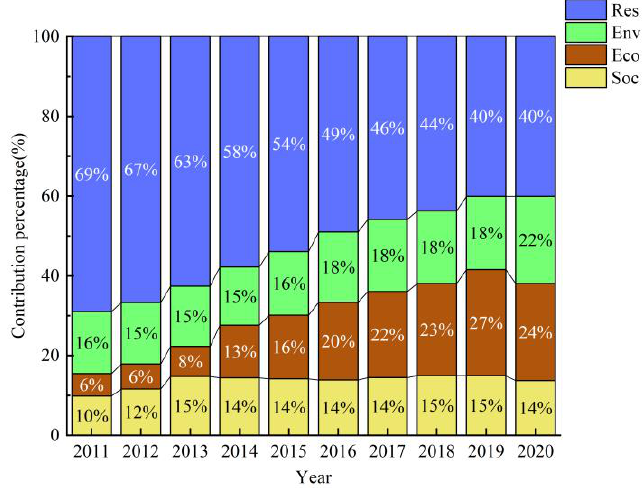
Figure 5. The contribution ratio of each subsystem to high-quality region development.